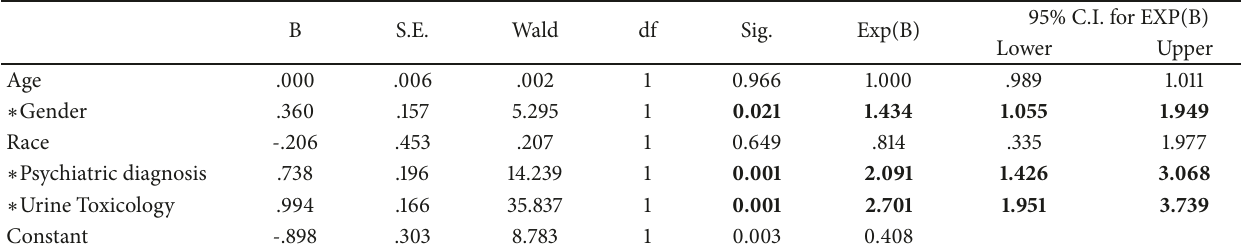
Table 3: Logistic regression analysis of variables.